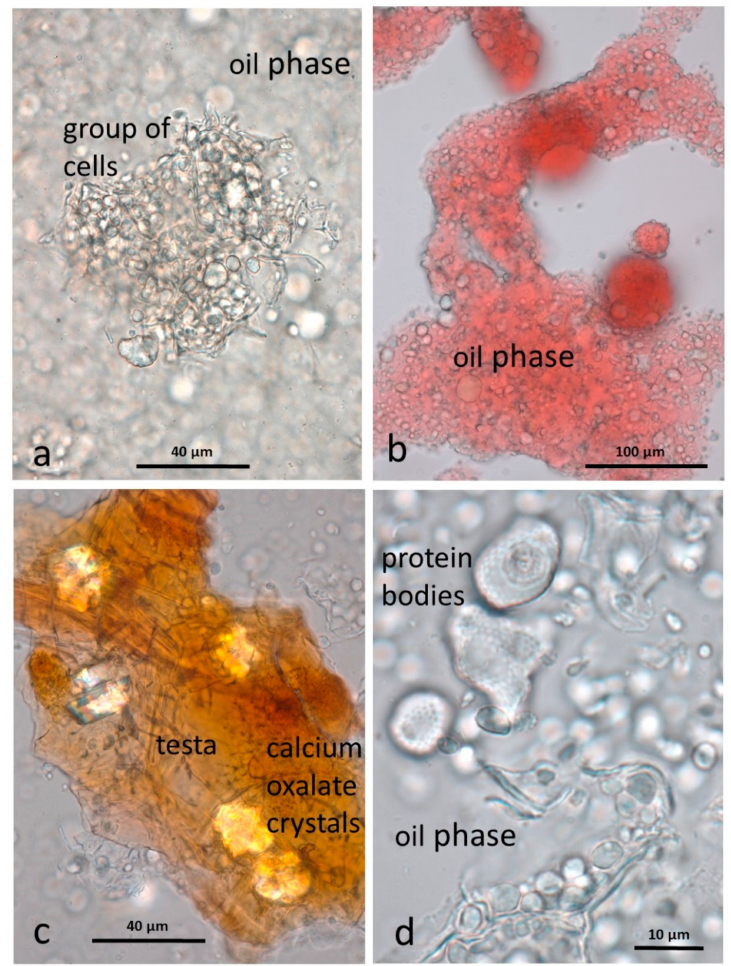
Figure 3. Almond butter baseline sample showing cellular fragments suspended in a lipid phase ( a ) a small group of kernel cells from which the lipid has been released ( b ) the lipid phase stained with Sudan IV ( c ) fragments of brown testa containing large calcium oxalate crystals ( d ) protein bodies and cell wall fragments in the lipid